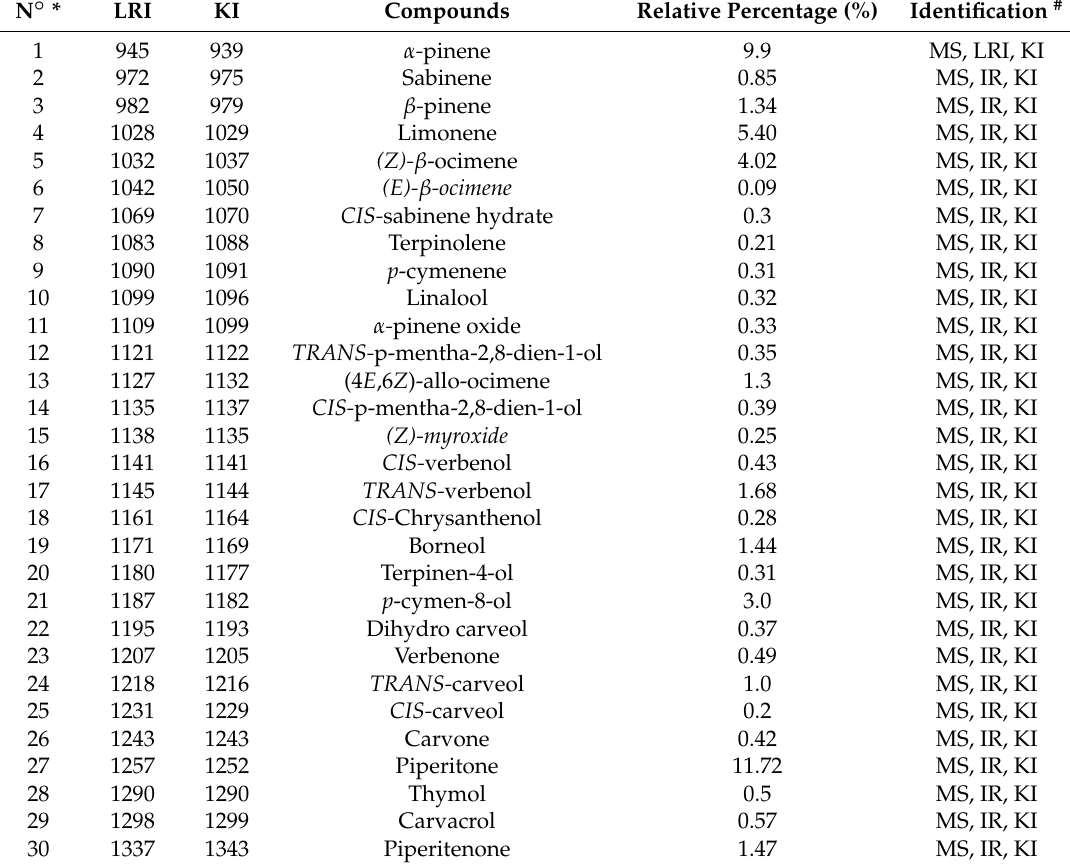
Table 1. Chemical composition of the essential oil of the leaves of Tithonia diversifolia